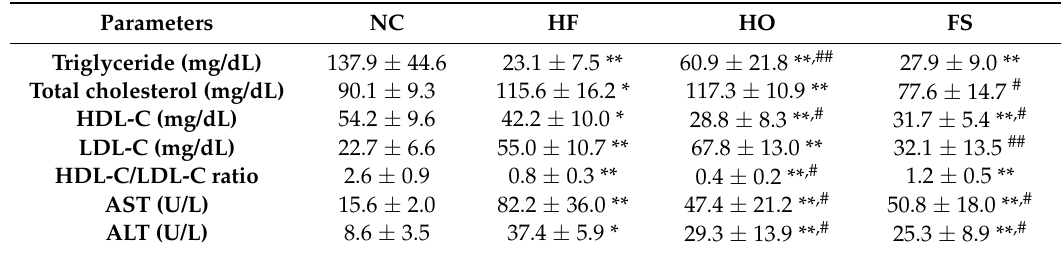
Table 4. The changes of plasma lipids and liver functional markers in HF-diet-fed rats supplemented with or without orlistat and RMD for 8